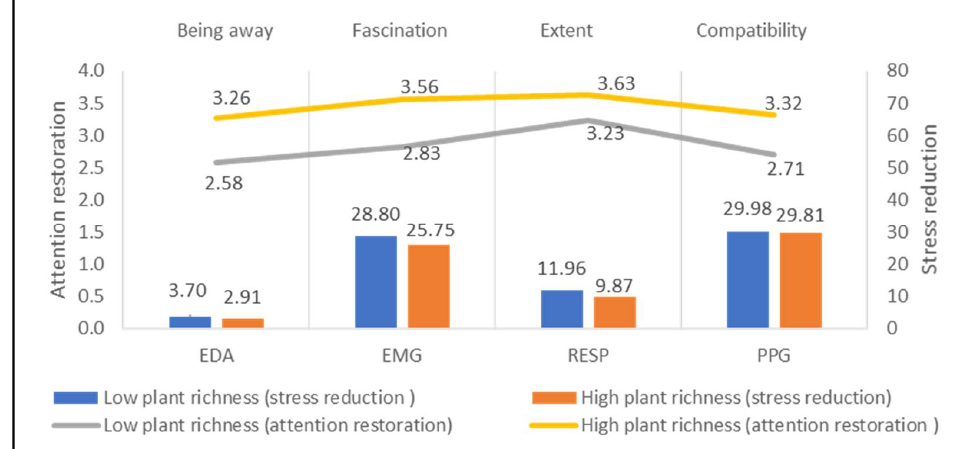
Figure 4. Impacts of plant richness on stress recovery and attention restoration.